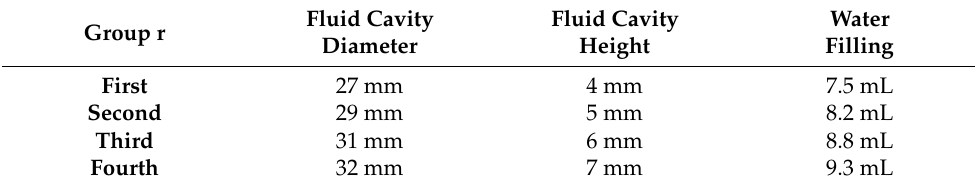
Table 2. Parameter list of four experimental prototypes.